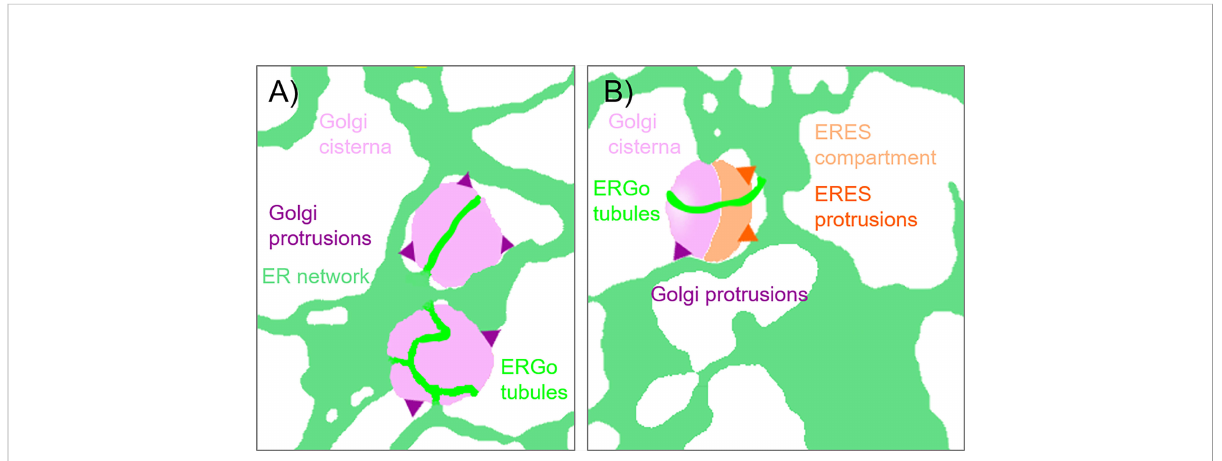
FIGURE 4 Schematic representation of ER-Golgi connections. The diagram indicates the various connections observed between ER and Golgi bodies: (A) ERGo tubules (dark green) labeled by the ER lumenal marker GFP-HDEL are connecting ER (light green) and Golgi cisternae (light purple). Dynamic protrusions from Golgi bodies (purple) are labelled with the medial/ trans -Golgi body marker ST-RFP. (B) Protrusions from ERES to ER (dark orange) can also be observed with the ERES/COPII components Sec24, Sec16 and Sar1a labelling a pre- cis -Golgi compartment (light orange).